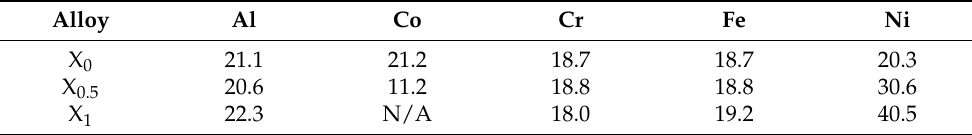
Table 1. Chemical composition (at.%) of the X 0 , X 0.5 , and X 1 alloys. Alloy